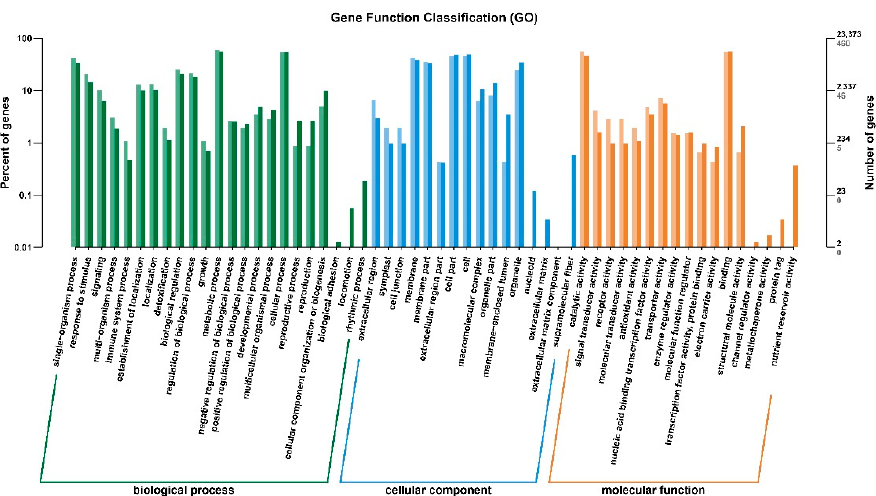
Figure 4. GO analysis of the functional enrichments of down- and up-regulated DEGs between pl vs. WT at late grain filling stage. Here, horizontal axis represents functional category and vertical axis represents the gene number in the category (right) and the percentage of the total genes on the annotation (left). Various colors signify various categories. Light color on the axis and histogram represents the differentially expressed genes, and dark color represents total number of genes in the respective categories.